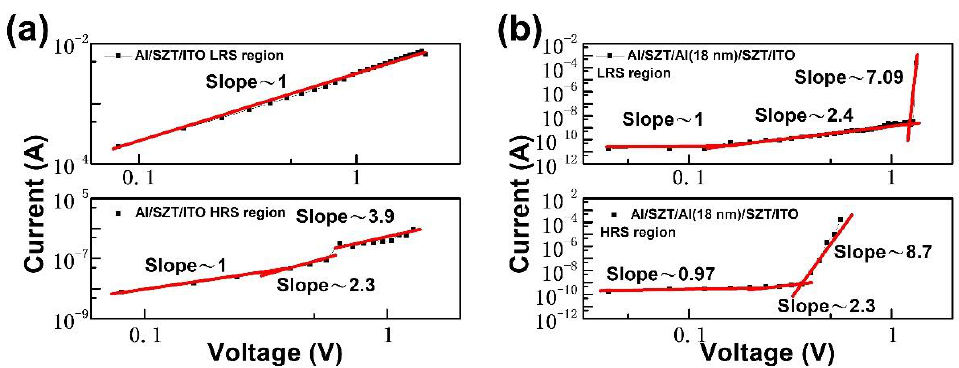
Al/SZT/ITO and Al/SZT/Al (18 nm)/SZT/ITO devices, and the I–V characteristic was plotted in log-log scale (Figure 5a,b). At low applied voltage, the slope of HRS was very close to linear. As the voltage increased, the current of HRS followed a voltage-square dependence. With the continuous increase in bias voltage, the current of HRS increased rapidly, corresponding to the steep increase in the current region. After the abrupt increase in its region, the current showed voltage-square dependence again. The fitting results of HRS illustrated that the current showed typical space-charge-limited conduction, which Figure 4. I – V switching curves of ( a ) Al/SZT/ITO, ( b ) Al/SZT/SZT/ITO, and ( c – f ) Al/SZT/different consists of the ohmic region (I ∝ V), trap-filled limit current (I ∝ V 2 ), and Child’s law region thicknesses (5, 18, 25, and 33 nm) of embedded metal – Al /SZT/ITO device RRAMs. (I ∝ V 2 ) [23,24].